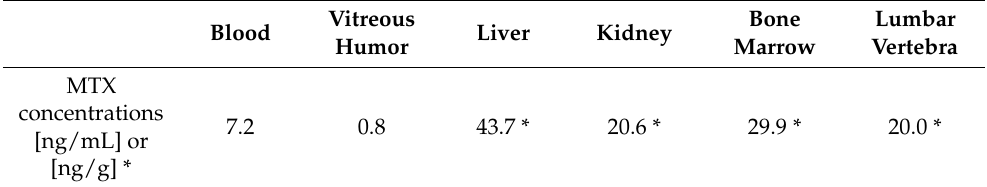
Table 4. Concentrations of MTX in body fluids and solid tissues of the deceased. Vitreous Liver Kidney Blood Humor